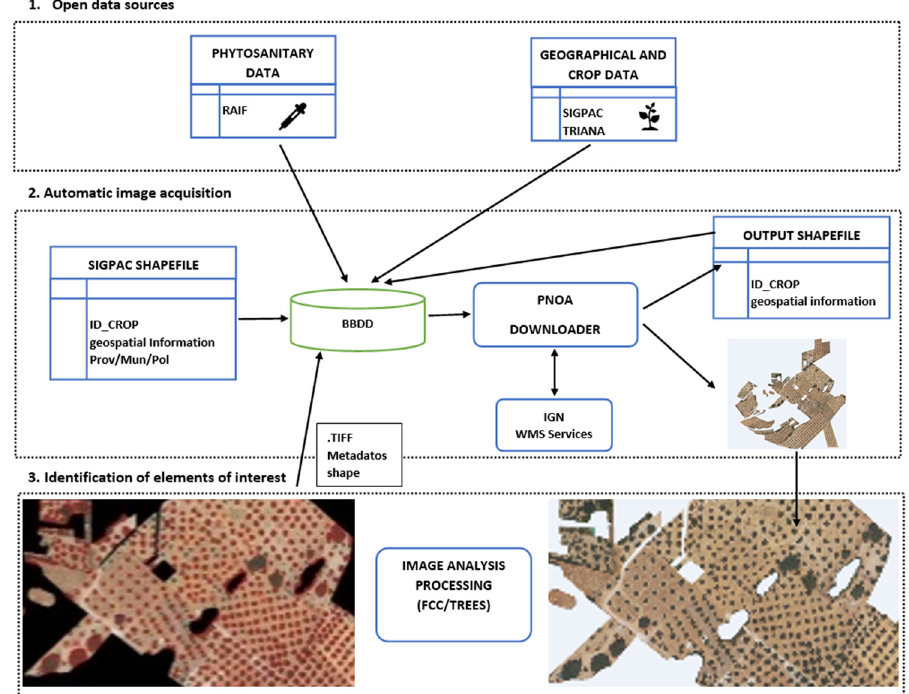
Figure 5. Characterization of the olive grove through PNOA orthophotos of 0.5 × 0.5 m resolution.